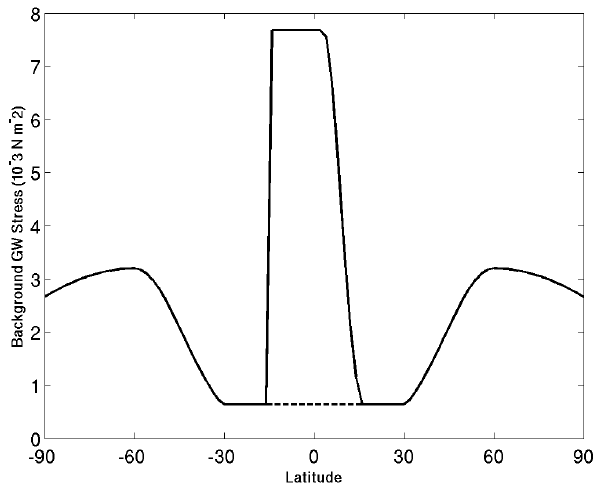
Figure 3. Background non-orographic drag from the MERRA (dashed line) and MERRA2 AGCM (solid line) simulations. The dashed line underlies the solid line outside of the